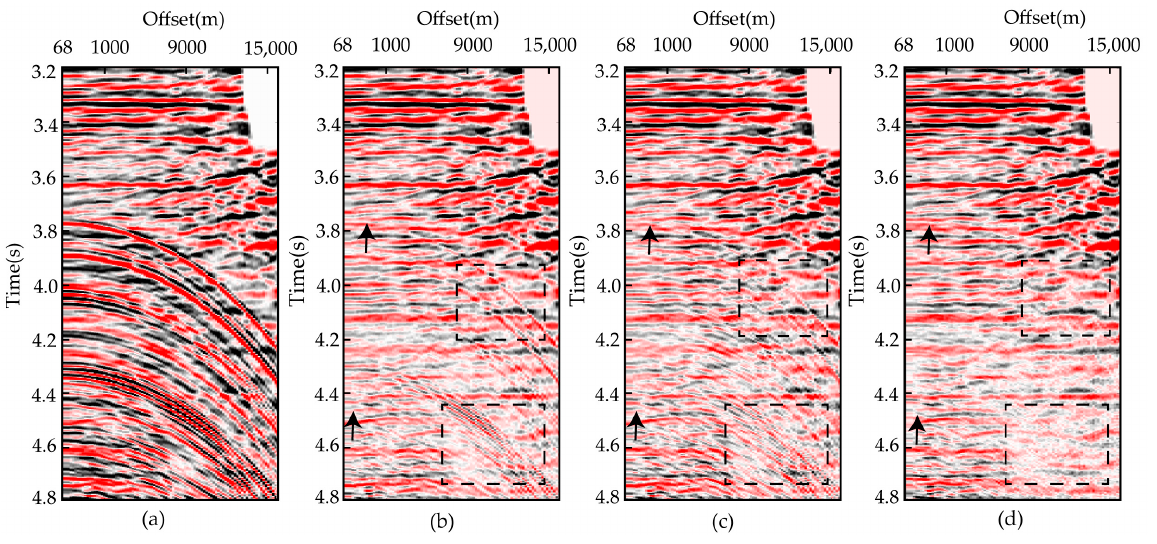
Figure 8. Multiple attenuation result: ( a ) CMP gather of marine real data; ( b ) by LSPRT method; ( c ) by SPRT L 1 method; ( d ) by SPRT L q 1 − L q 2 method. The black arrows indicate the continuity of the seismic events are improved in the Figure 8d.